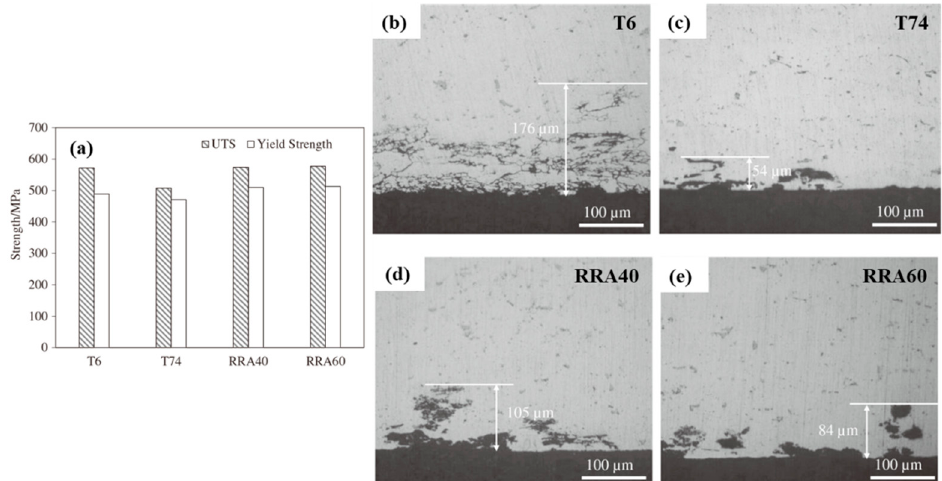
Figure 19. ( a ) Mechanical properties; Intergranular corrosion morphology of the alloy under different aging treatment conditions: ( b ) T6, ( c ) T74, ( d ) RRA40, ( e ) RRA60. (Reprinted with permission from ref. [120]. Copyright 2015 Elsevier).